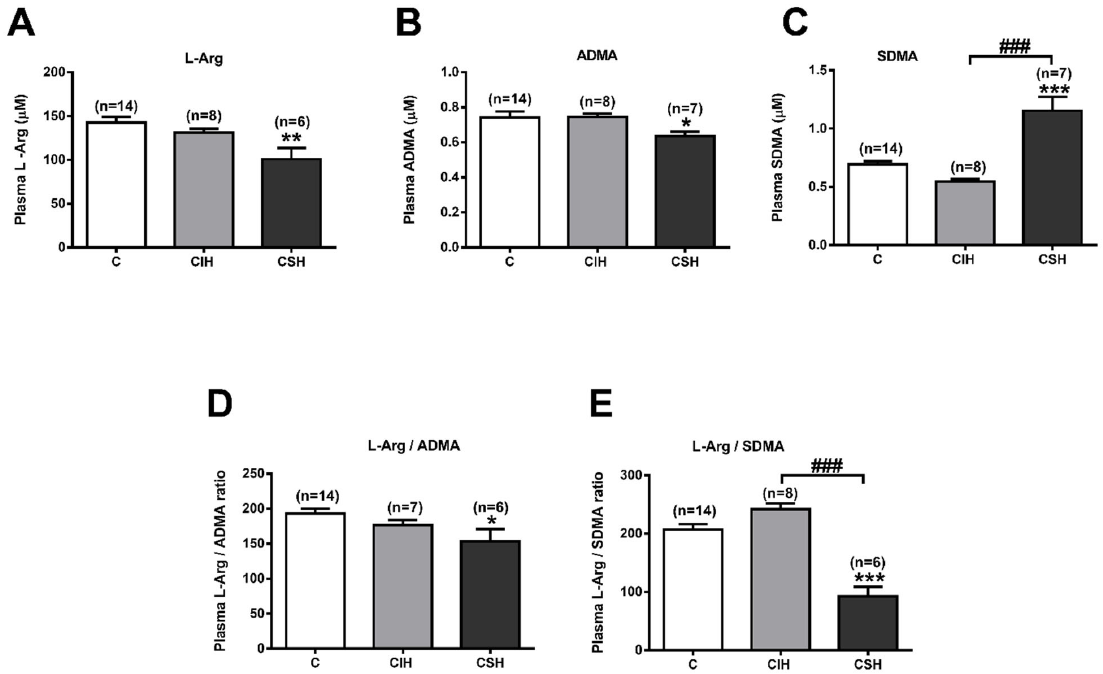
Figure 5. L-Arginine and arginine-methylated metabolites in plasma. ( A ) Plasma levels of L-Arginine (in µ M). ( B ) Plasma levels of ADMA (in µ M). ( C ) Plasma levels of SDMA (in µ M) measured by HPLC-FD. ( D ). Ratio L-Arginine/ADMA. ( E ). Ratio L-Arginine/SDMA in C, CIH, and CSH rats. Data are expressed as mean ± SEM ( n = 8–14). * p < 0.05, ** p < 0.01, *** p < 0.001 vs. C one-way ANOVA with Tukey multi comparison test; ### p < 0.001 CIH vs. CSH, One Way ANOVA. Hypoxia evoked a similar pattern for the concentration of L ‐ arginine in pulmonary arteries as in the plasma: it tended to decrease in both the CIH and CSH groups, although its effects were not significant in either group (Figure 6A; p > 0.05). The concentration of ADMA in both experimental groups (Figure 6B) decreased from 35.4 ± 13.5 pmol/mg PA in the control group to 8.4 ± 1.7 and 1.3 ± 0.1 pmol/mg PA in CIH and CSH, respectively. Conversely, the SDMA levels (Figure 6C) tend to increase in the CIH group (9.7 ± 1.5 pmol/mg PA), while they tend to diminish in the CSH group (2.6 ± 0.2 pmol/mg PA) vs. the control group (6.1 ± 1.7 pmol/mg PA). L ‐ Arg/ADMA ratio (Figure 6D) increases in the CSH group (171.8 ± 15.4 vs. 26.9 ± 8.7 in C, p < 0.001) while the L ‐ Arg/SDMA ratio (Figure 6E) decreases in the CIH group (31.5 ± 3.1 vs. 79.7 ± 17.6 in C group, p < 0.05).